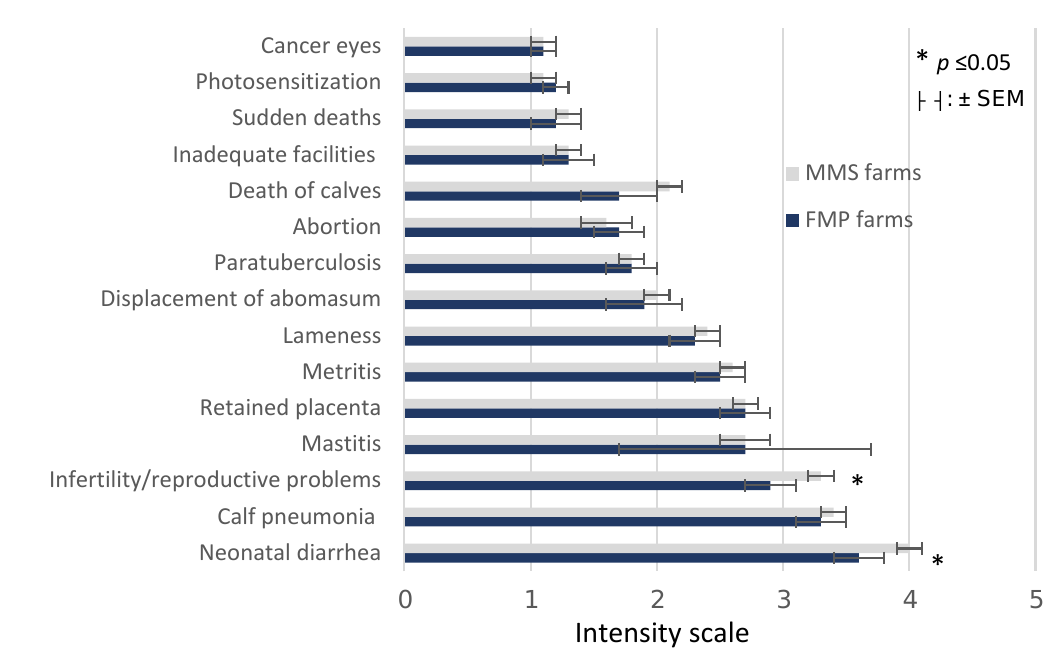
Figure 3. Score intensity scale of major problems suffered in 2020, according to the farmers’ perceptions, in dairy farms with mobile (MMS) versus fixed (FMP) milking systems.